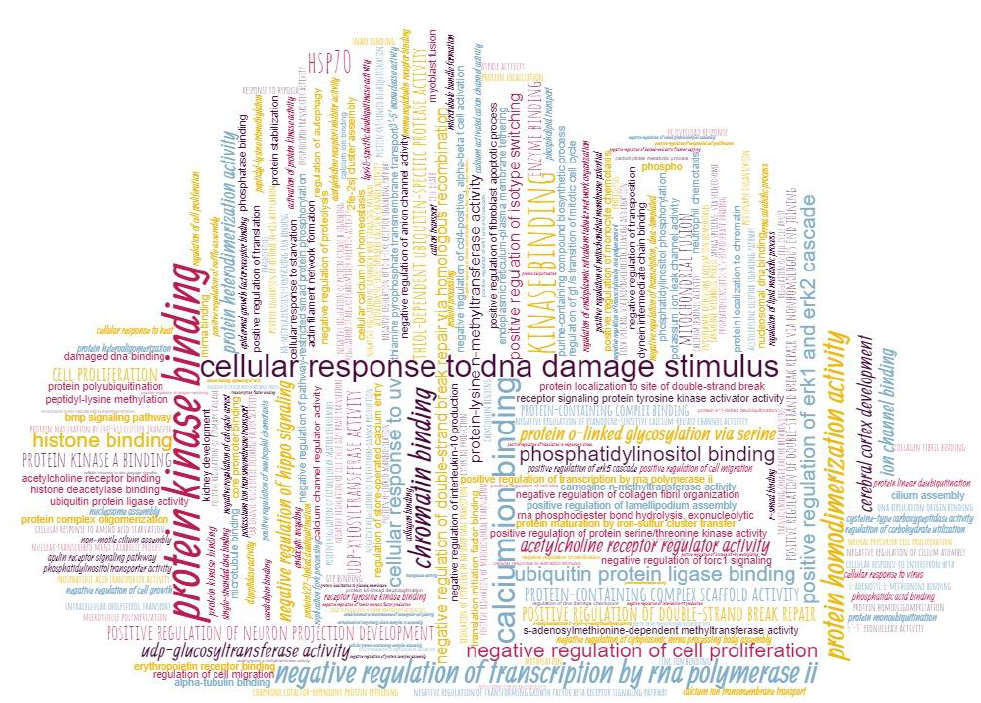
Figure 2. A cloud of biological functions for proteins. The data presented refer to 1392 proteins whose functional annotation appeared in neXtProt from the beginning of 2016 to the beginning of